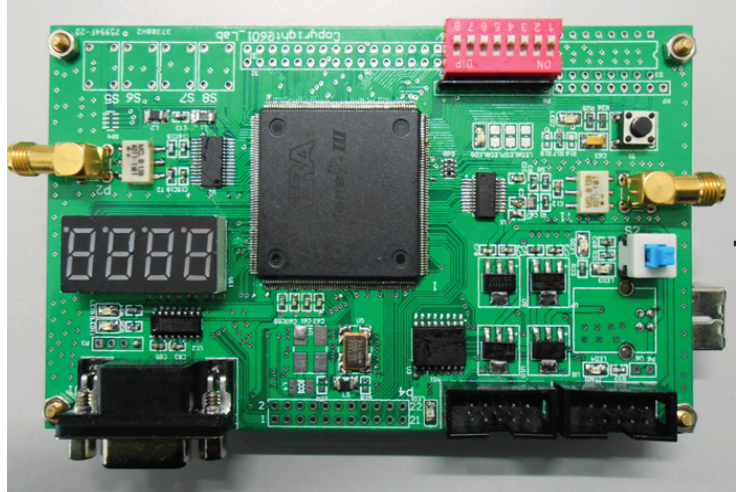
Figure 24. The Physical map of the hardware platform.